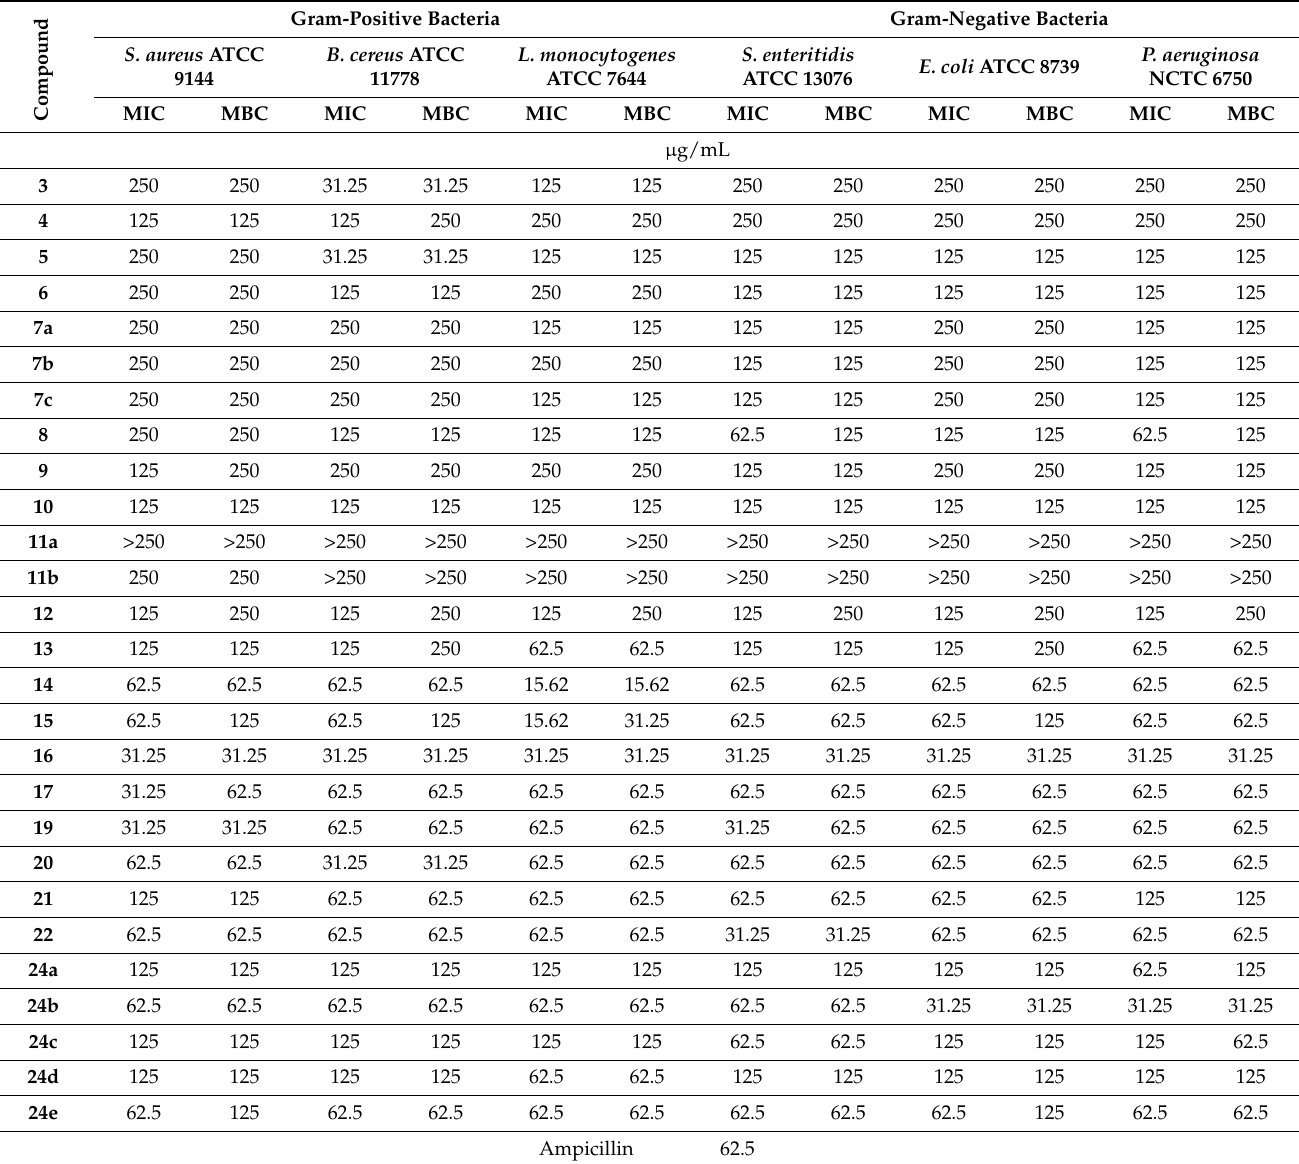
Table 2. Minimal inhibitory concentrations (MIC) as well as minimal bactericidal concentrations (MBC) of 5-oxopyrrolidine derivatives 3 – 24 against various bacterial